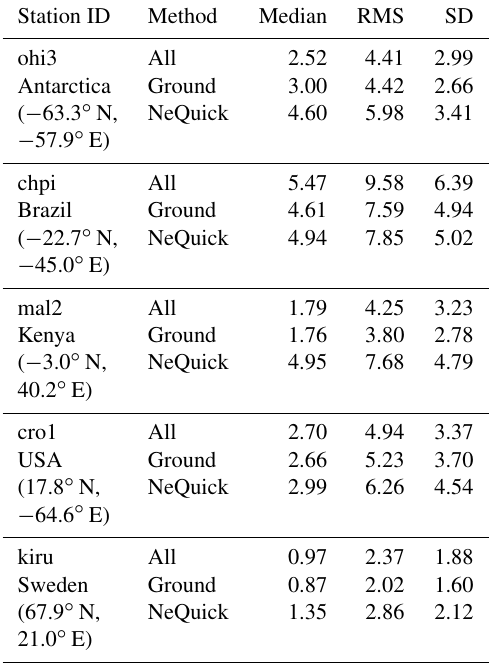
Table 4. The statistics of the absolute sTEC residuals in TECU for DOYs